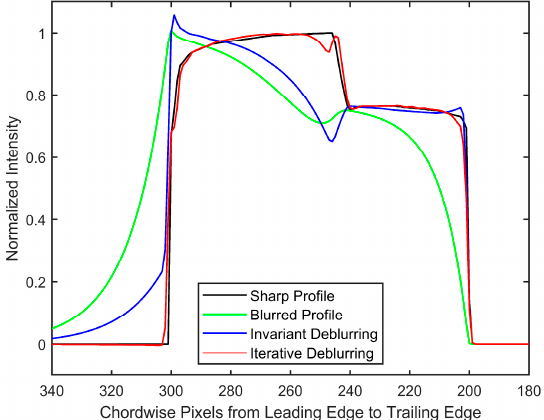
Figure 13. Comparison of applied and restored intensity values at r / R = 0.95. The iterative deblurring result is after 13 iterations. Rotation is toward increasing pixel values.